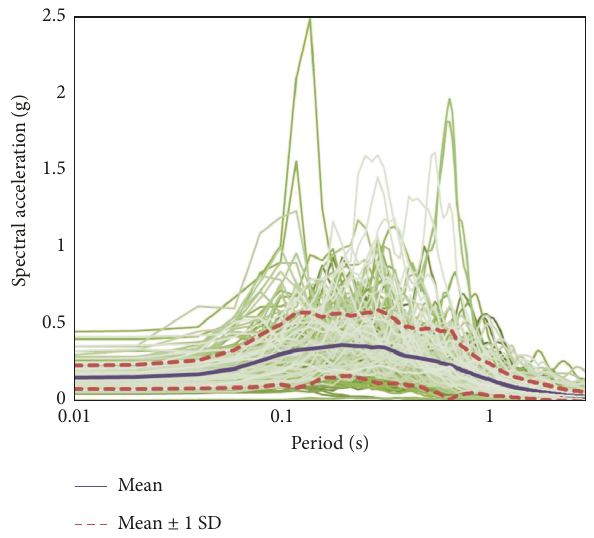
Figure 4: Acceleration response spectra of the selected earthquake